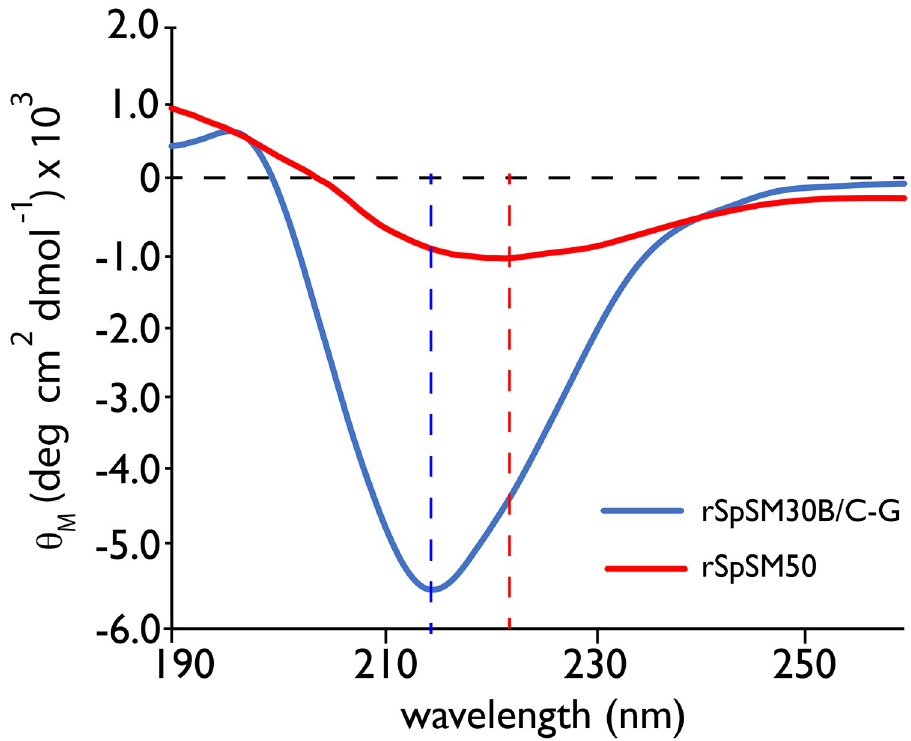
Fig 1. Far-UV circular dichroism spectra of rSpSM30B/C-G (7.5 μ M) and rSpSM50 (3 μ M) proteins in 100 μ M HEPES, pH 8.0. Dashed line extrapolates the ellipticity minima for each protein.